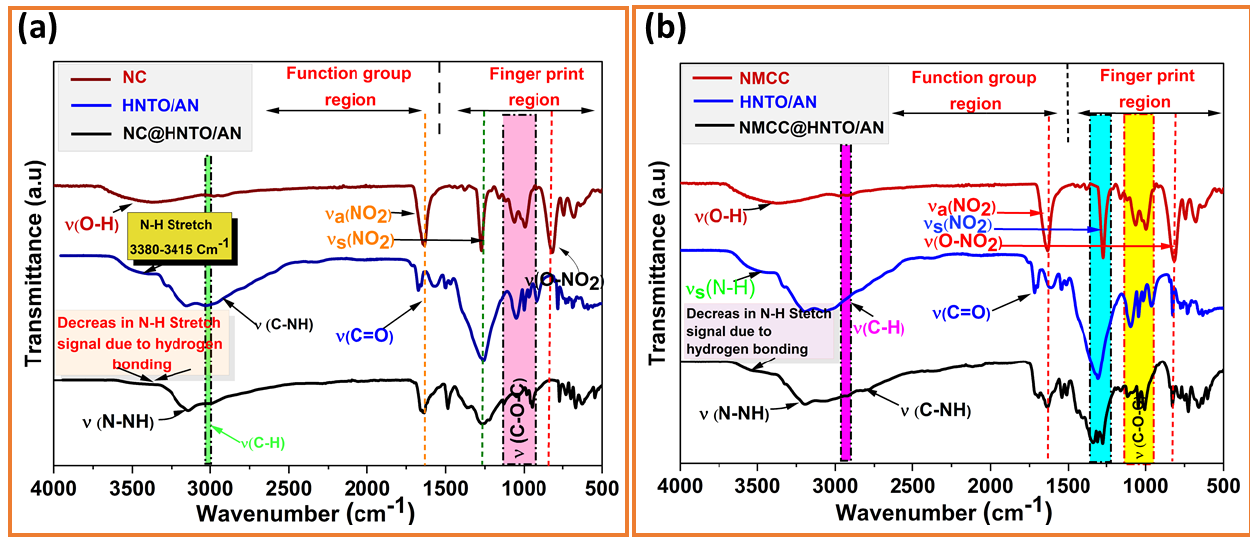
Figure 3. FTIR spectra of ( a ) the NC@HNTO/AN mixture and its pure constituents; ( b ) the NMCC@HNTO/AN mixture and its single constituents.